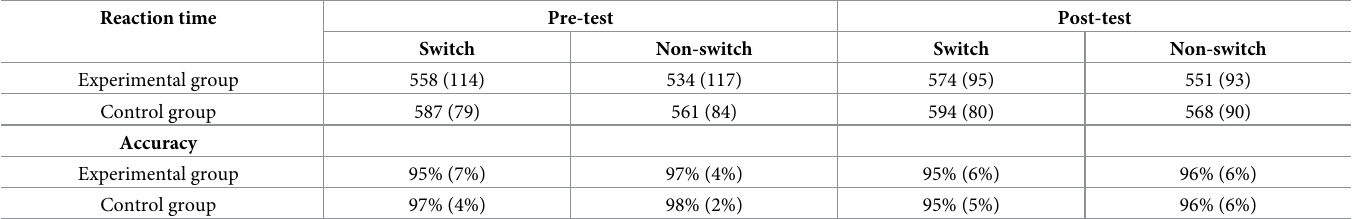
Table 2. Behavioral performance in the task switching task. Means of reaction times and accuracy (standard deviations in parentheses) for the experimental and control groups at the pre- and post-test sessions. Reaction